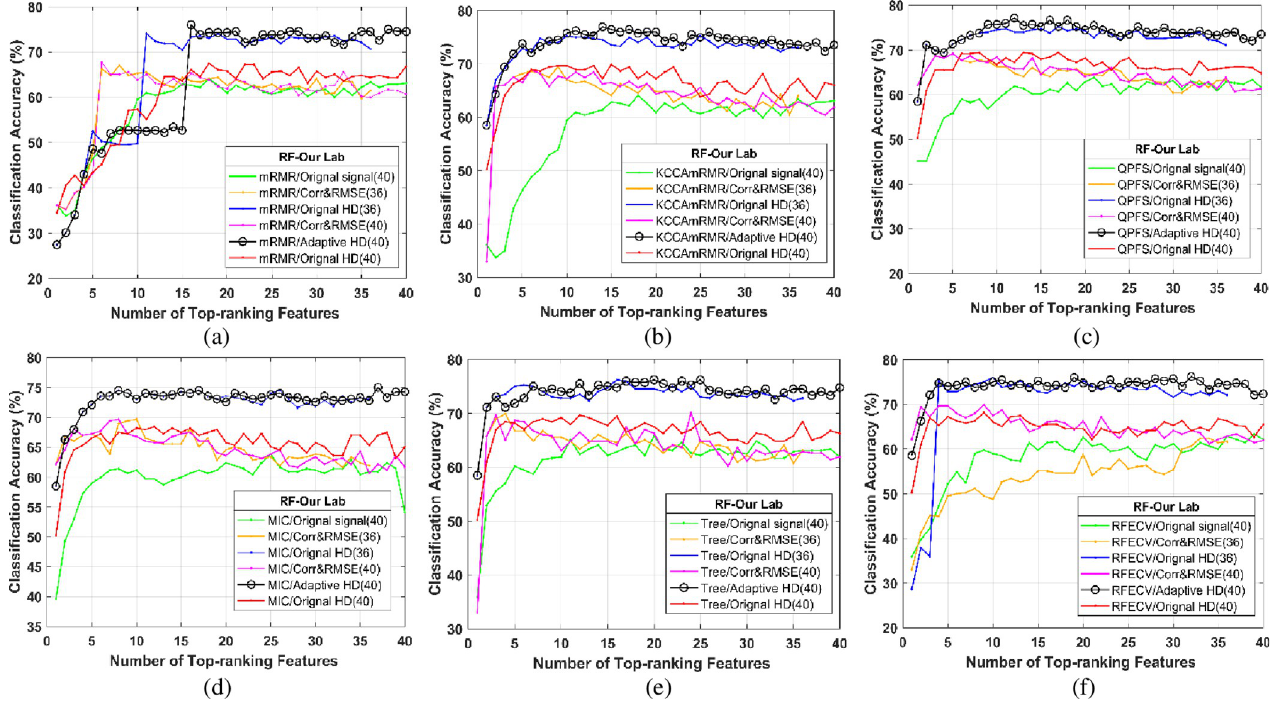
Fig 10. The average classification accuracy versus the number of top-ranking features selected by mRMR, KCCAmRMR, QPFS, MIC and Tree and RFECV using RF classifier from our Lab data.